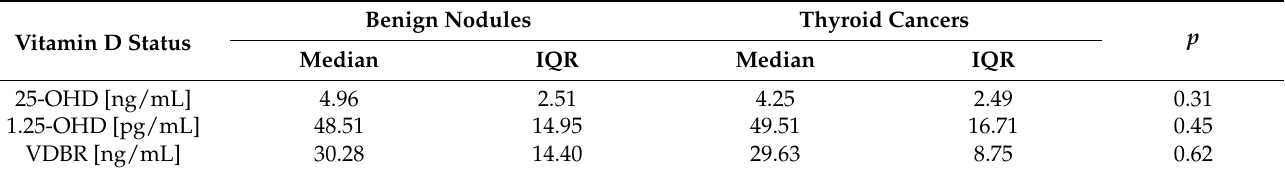
Table 2. Vitamin D status between patients with benign nodules and thyroid cancer.